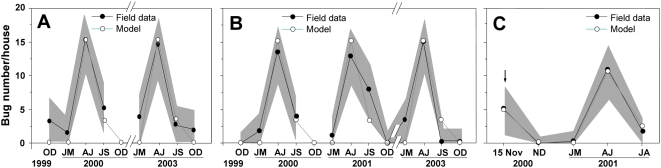
Fit and test of the model.(A) Fit of the model with no control actions. (B) Test of the predictive power of the fitted model. (C) Fit of the model with insecticide spraying. Field data are given with a 95% confidence interval (shaded area).